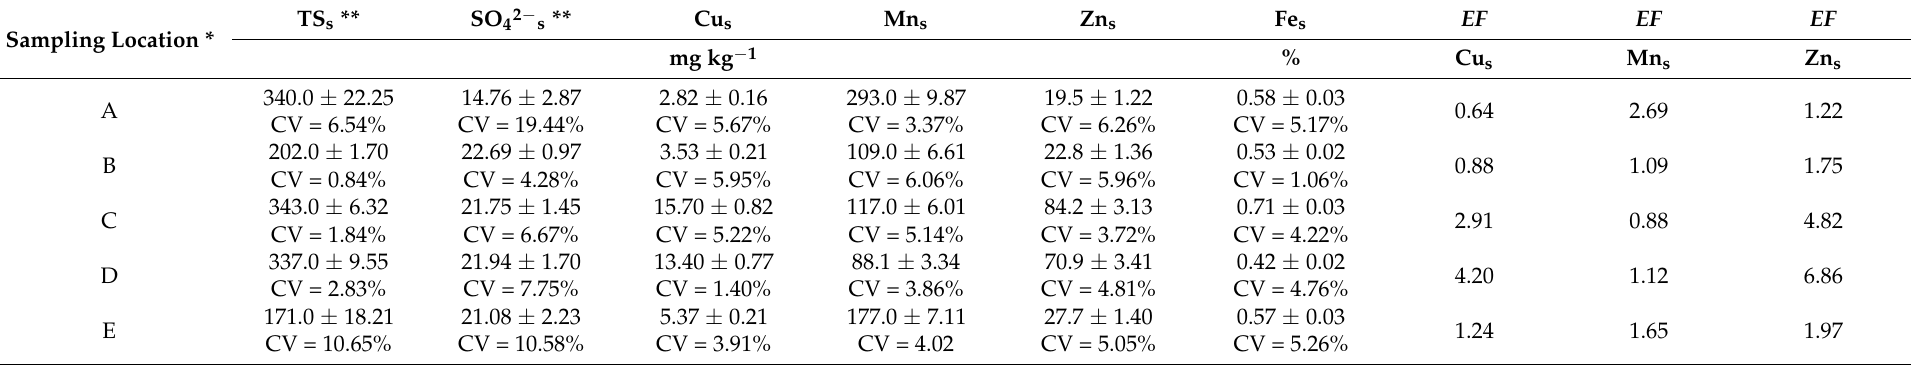
Table 1. Total content of sulphur (TS s ), sulphate sulphur (SO 42- s ), Cu s , Mn s , Zn s (mg kg − 1 ), Fe s (%) in soil samples, and the values of enrichment factor ( EF ). Sampling Location *